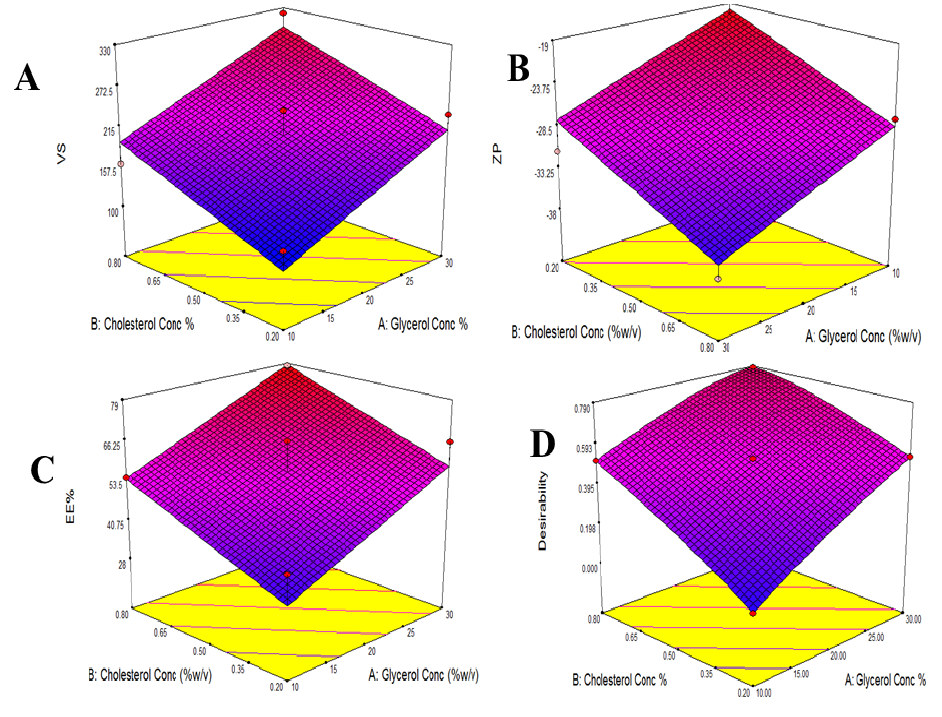
Figure 1. Response surface plot for the effect of Glycerol concentration and Cholesterol concentration on VS ( A ), ZP ( B ), EE% ( C ), and Desirability ( D ).